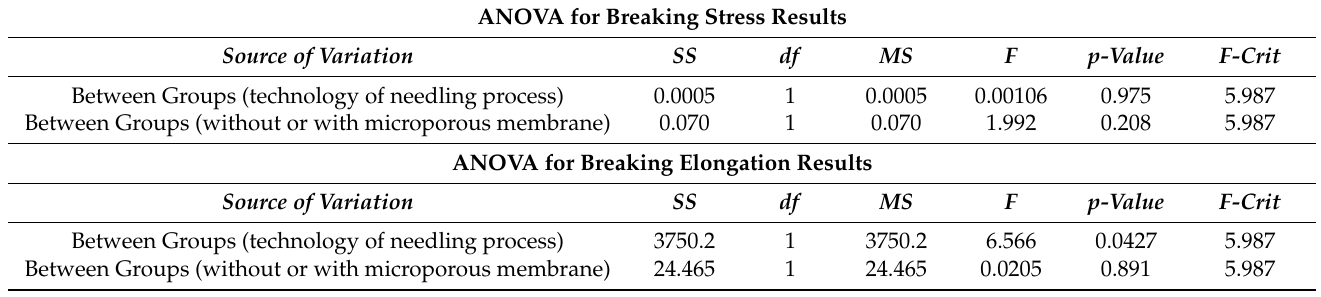
Table 6. Results of one-way ANOVA.